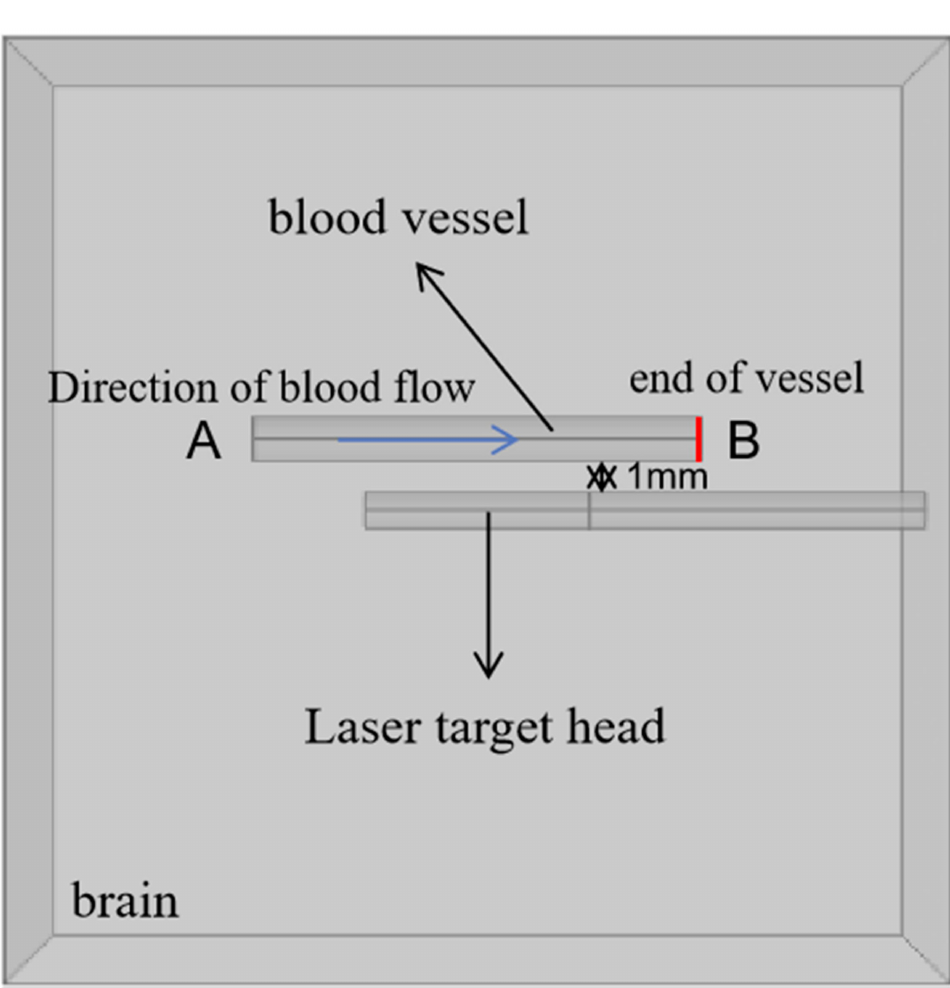
Figure 5. Location of vascular thermal